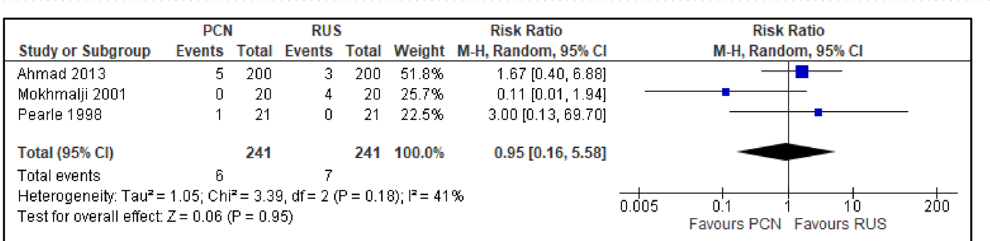
Figure 15. Comparison between PCN and RUS for outcome urgency.